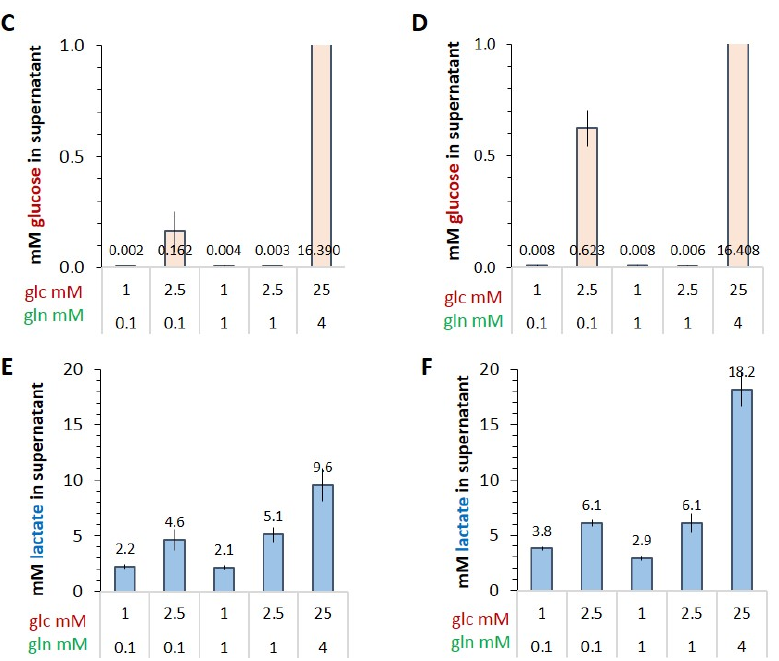
Figure 1. Quantification of the Warburg effect in conditioned media from MCF-7 and MDA-MB-231 cells. Glucose and lactate were quantified in the culture supernatants after a 72 h incubation with the indicated combinations of glucose/glutamine. ( A , B ) Cell number per 2-mL culture; ( C , D ) glucose concentration remaining; ( E , F ) lactate concentration accumulated in the medium. Averages with the s.e.m. are results from three independent experiments.